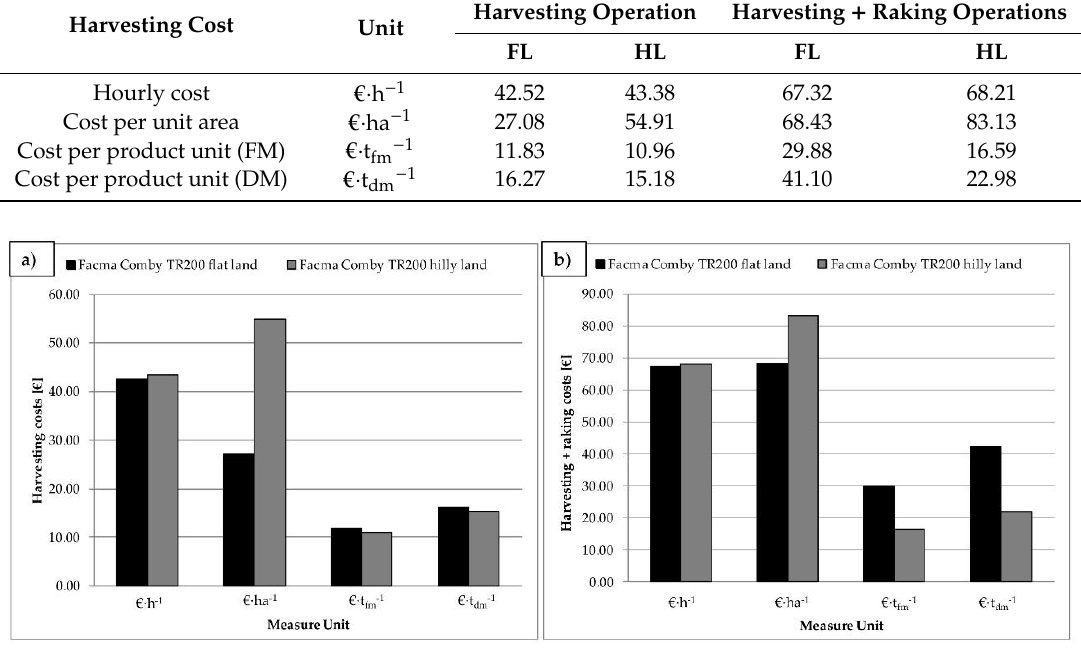
Figure 4. ( a ) Cost analysis regarding only the harvesting operation with the Facma Comby TR2000 towed shredder. ( b ) Cost analysis also considering the preliminary raking operation.